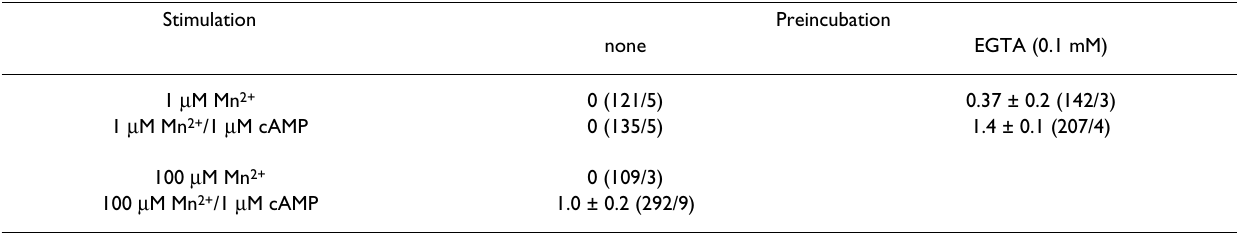
Table 2: Rate of basal and cAMP-induced Mn 2+ -influx. Amoebae were challenged with 1 or 100 µ M Mn 2+ either with or without 1 µ M cAMP. Cells were preincubated with 0.1 mM EGTA as outlined in Methods. Mn 2+ quenching of fura-2-dextran fluorescence was tested in H5-buffer and is expressed as decrease in fluorescence units/sec (mean ± s.e.m.). Numbers in brackets give number of cells tested and number of